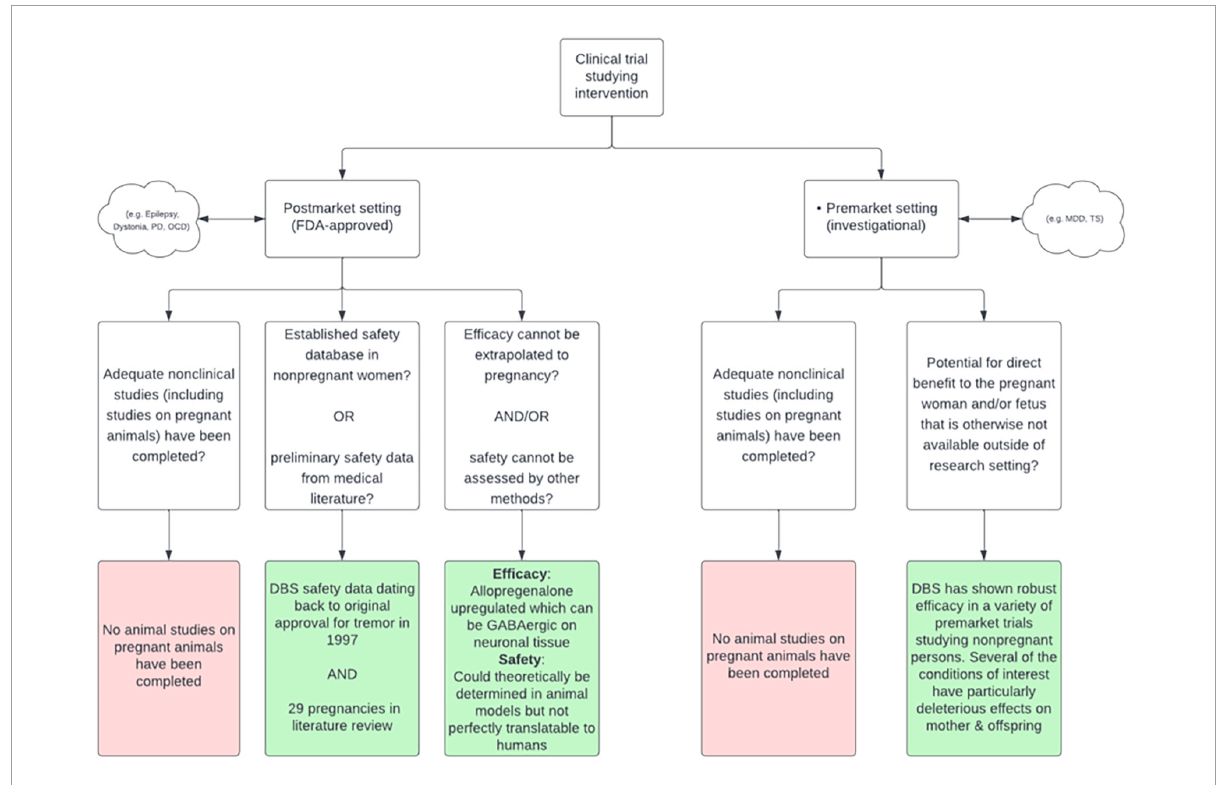
FIGURE3 Flow diagram describing 2018 draft by FDA on the inclusion of pregnant persons in clinical trials. PD, Parkinson’s disease; OCD, obsessive-compulsive disorder; MDD, major depressive disorder; TS, Tourette’s syndrome.